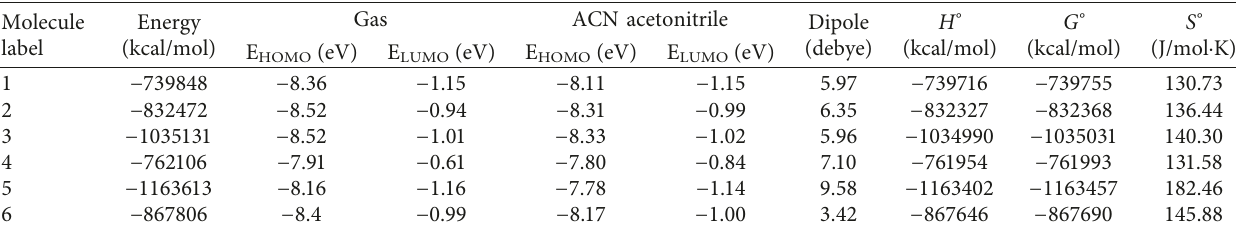
Table 1: The structure-properties relationships in gas phase reflecting the effect of molecular structure on the associated energy and thermodynamic parameters, which are important for molecular characterization (HOMO-LUMO values of geometry-optimized molecules in acetonitrile (ACN) are also